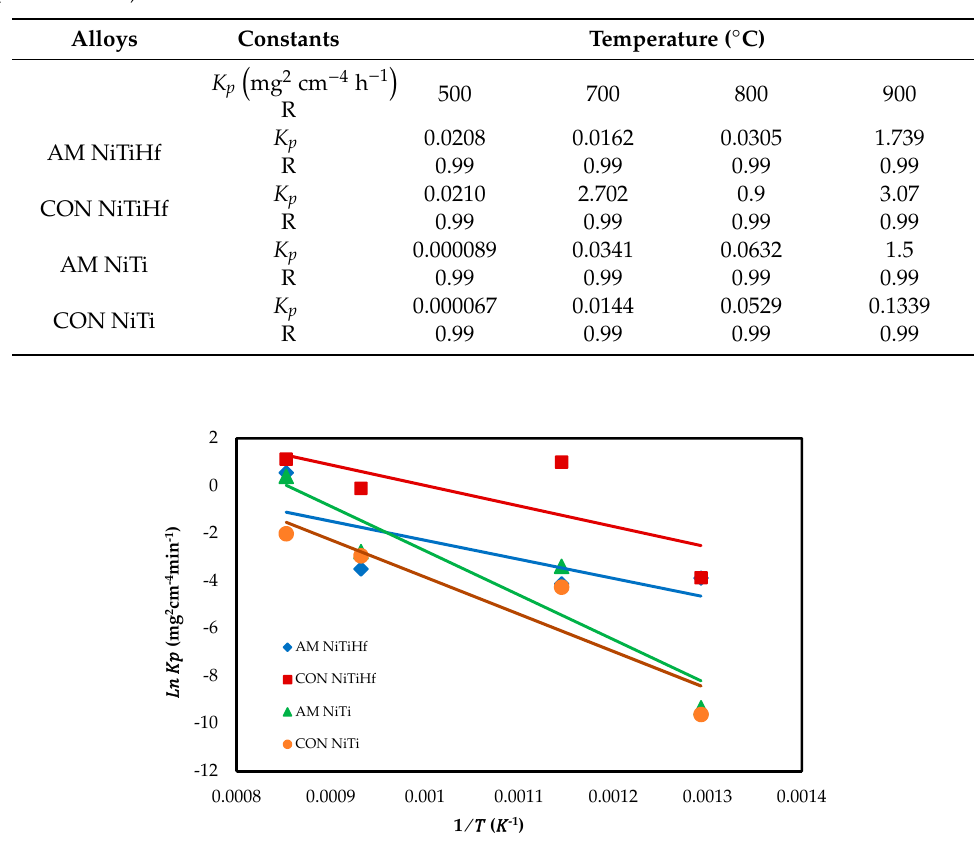
Figure 3. Thermogravimetric curves of isothermal oxidation of AM (dash line) and CON (solid line) NiTi alloy at 500, 800, and 900 °C. Table 2. Calculated parabolic rate constants for AM and CON NiTiHf and AM NiTi. K p unit is (cid:16) − 1 (cid:17) mg 2 cm − 4 h .